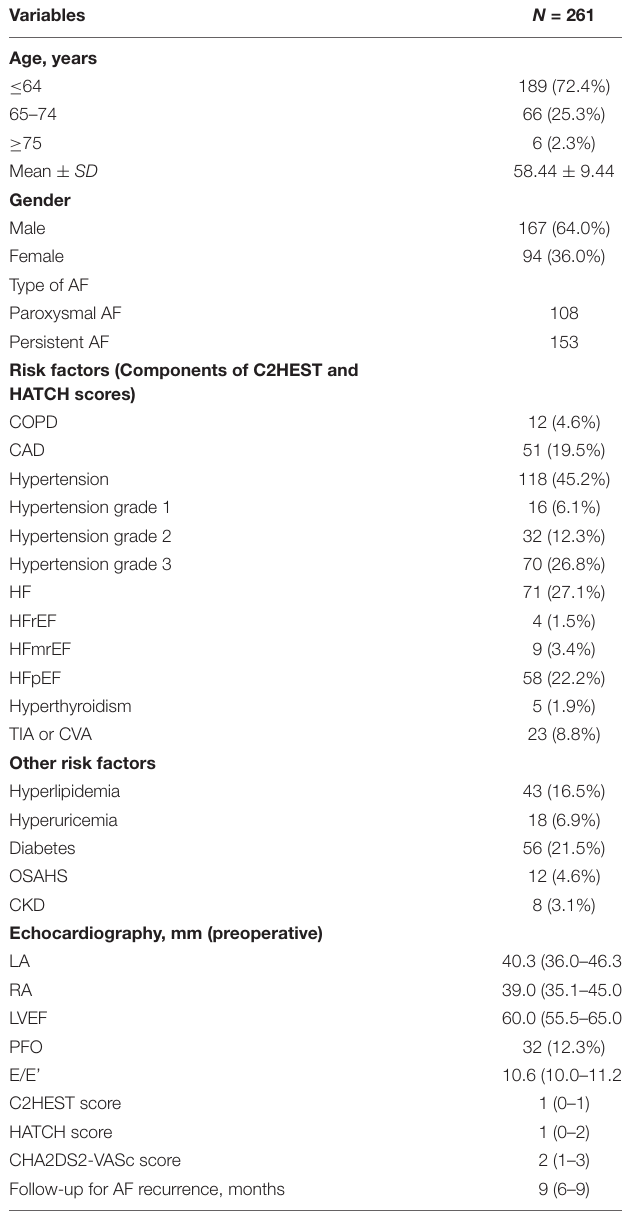
TABLE 1 | Baseline characteristics of study